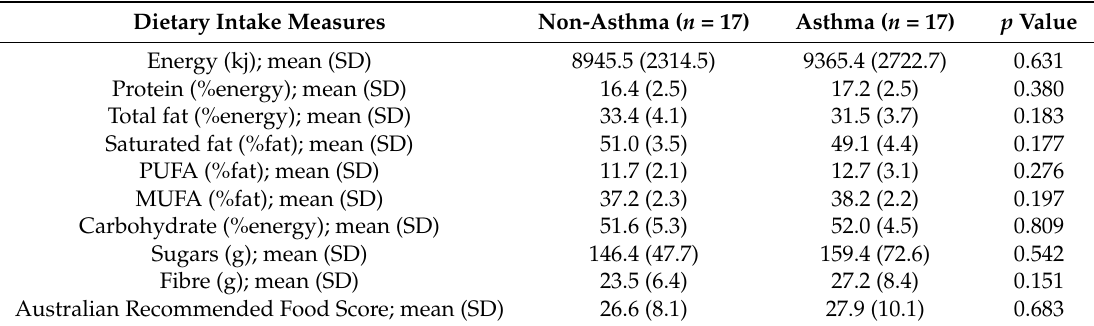
Table 4. Dietary intake measured by the Australian Child and Adolescent Eating survey in children with and without asthma, referred for an overnight polysomnography.